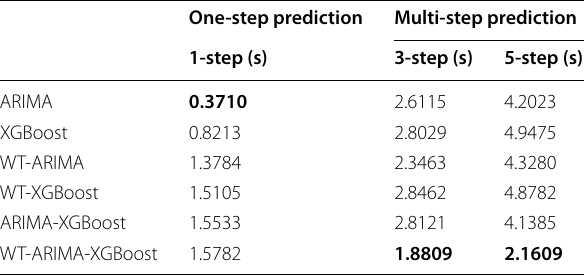
Table 4 Time performance of layer actions response time in training and testing time of six